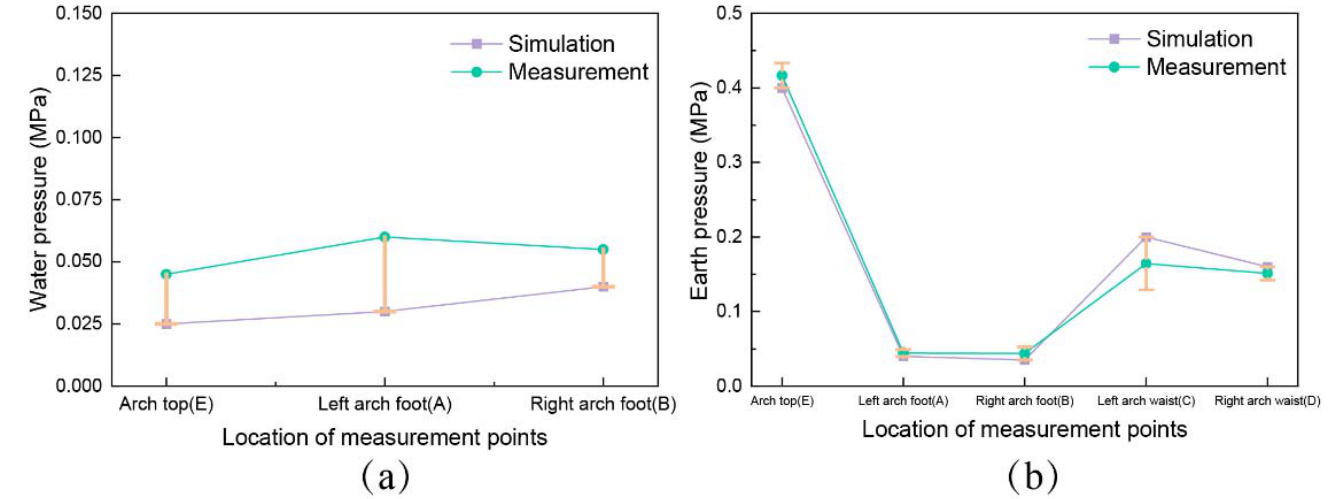
Figure 25. Comparison of numerical calculation results and field monitoring results for different locations: ( a ) water pressure results comparison graph; ( b ) earth pressure results comparison graph.